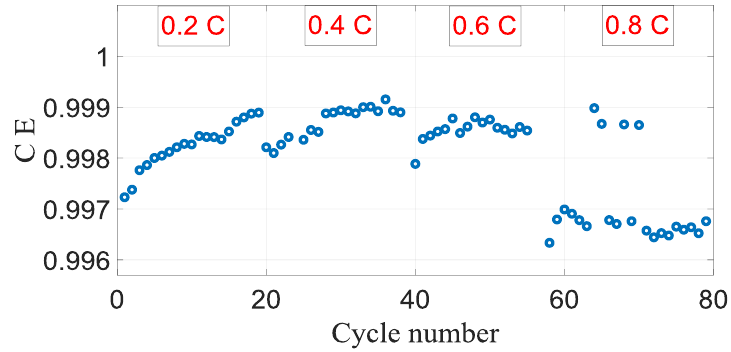
Figure 9. A comparison between coulombic efficiencies for different current rates.